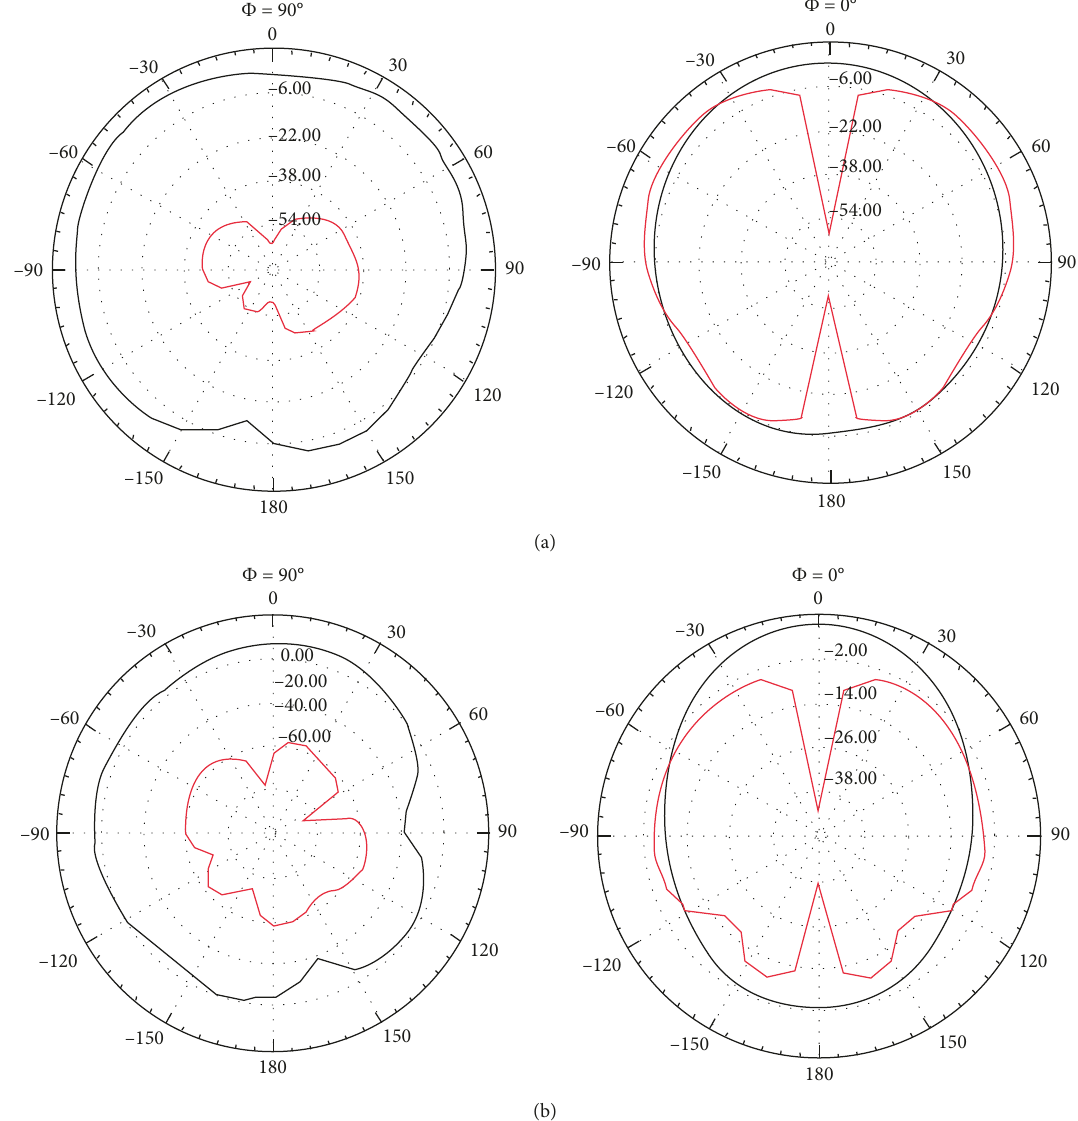
Figure 7: Polar plots of nanopatch antenna at the frequency of (a) 160THz and (b) 197THz. Black curves represented copolar and red curves represented